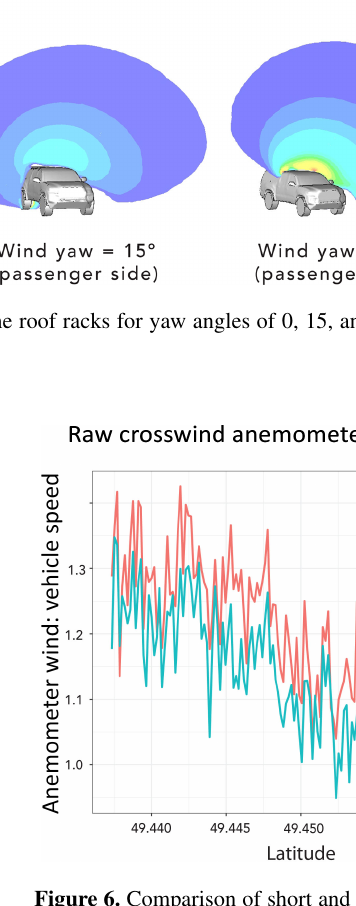
Figure 6. Comparison of short and tall anemometer measurements in